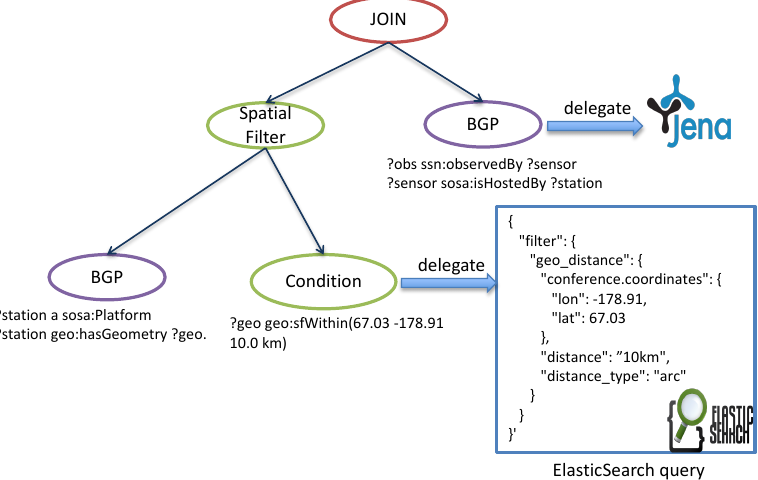
Figure 12. Delegating the evaluation nodes to different backend